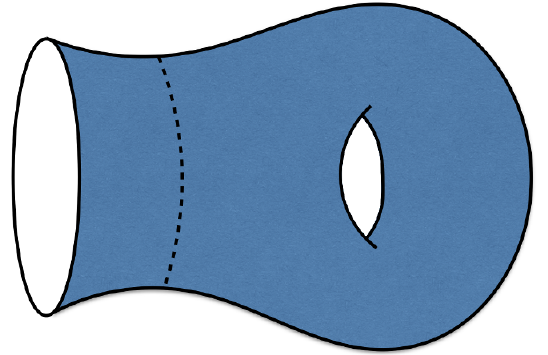
Figure 2 . A cartoon of the t = 0 surface for the toroidal geon state. The geometry consists of a single asymptotically AdS boundary separated from a genus one surface by a black hole horizon (dashed